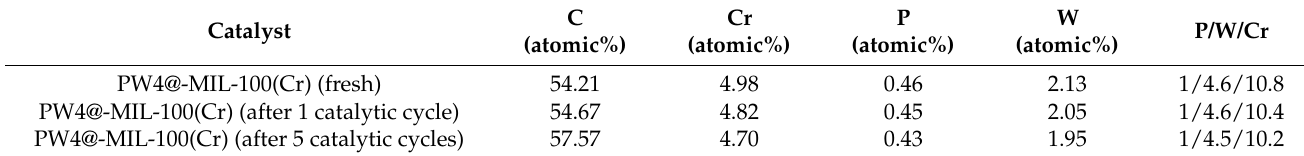
Table 6. Textural properties of fresh and spent PW4@MIL-100(Cr) catalysts .